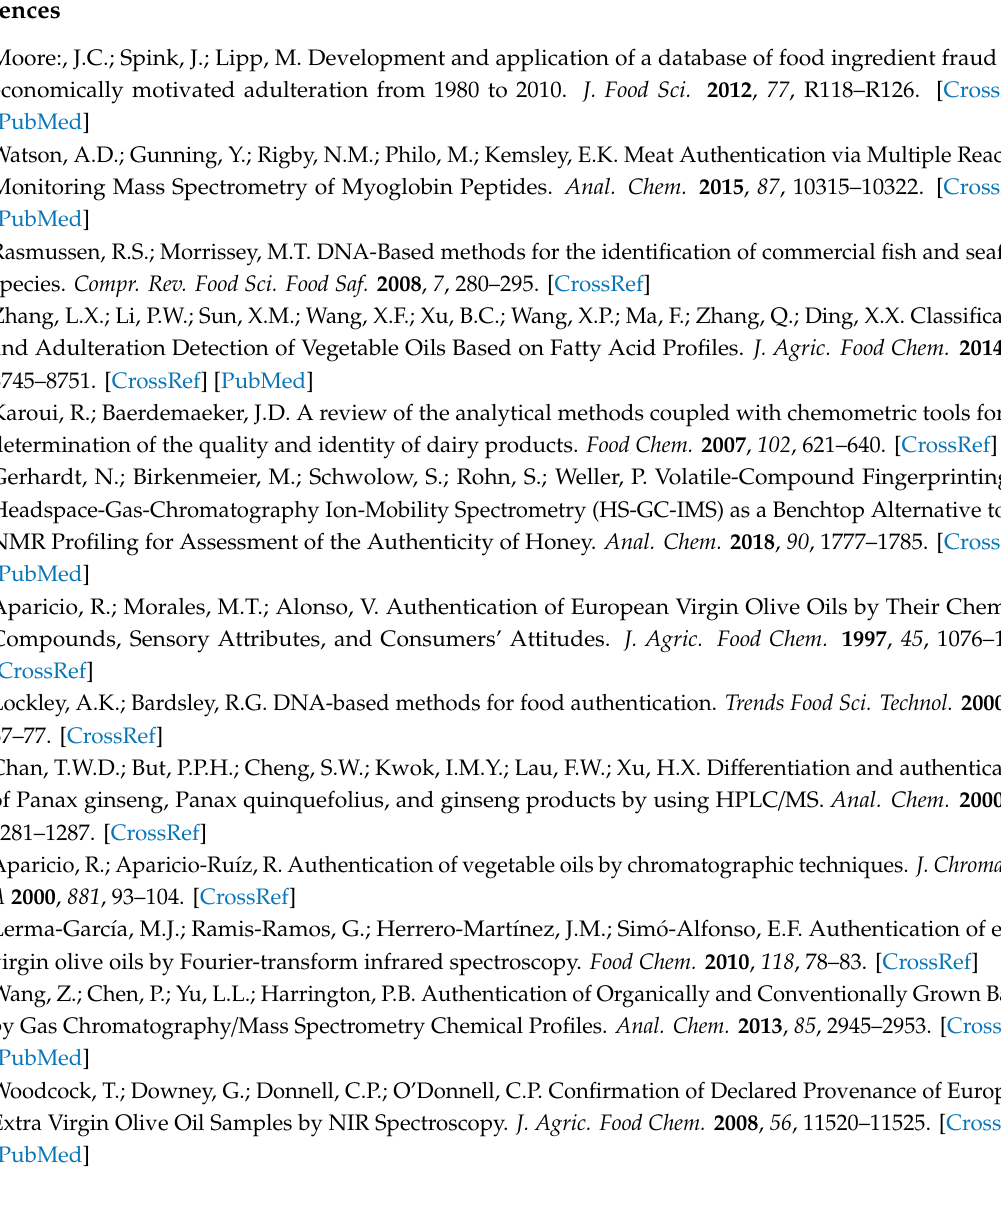
Figure S1: T-test plot of significant di ff erences between the variables, Table S1: Detailed information of the commercial oil samples used, Table S2: Retention times, scan parameters, and calibration curves of the target compounds, Table S3: Observation of metabolites in the isoflavonoids biosynthesis